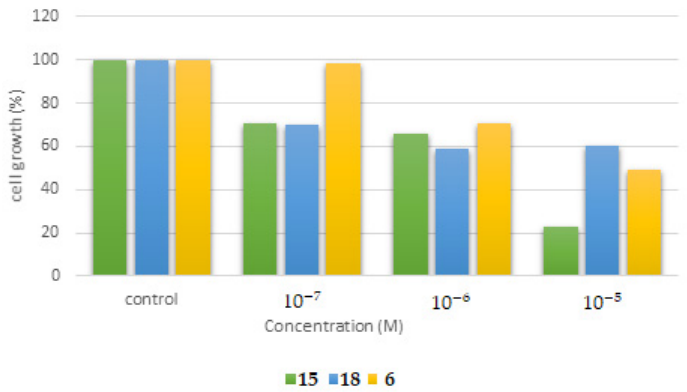
Figure 13. Cell growth kinetics of MRC-5 cells exposed for 48 h at various concentrations in culture to compounds 15 , 18 , and 6 .